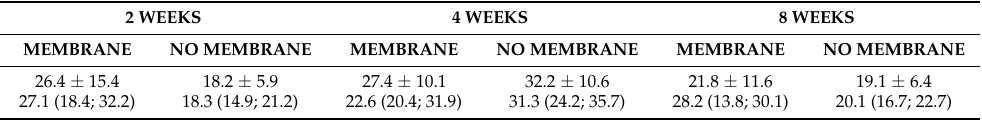
Table 3. Mean values ± standard deviations and medians (25%; 75% percentiles) of mineralized new bone percentages (%) in the osteotomy region after 2, 4, and 8 weeks of healing.